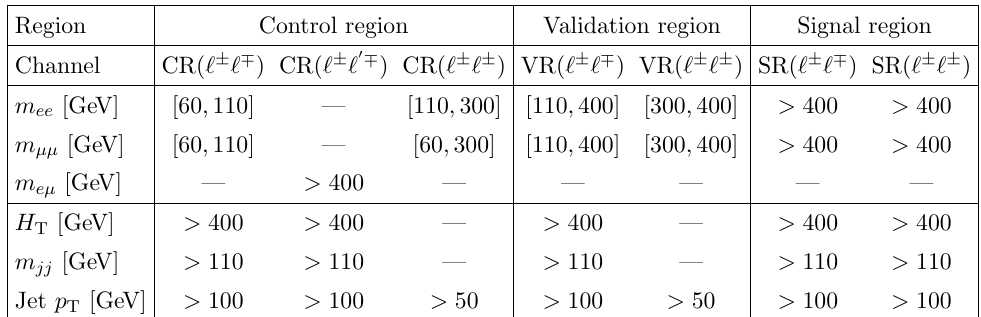
Table 2 . Summary of all regions de(cid:12)ned in the analysis divided into the OS and SS channels. The table is split into two blocks: the top half indicates the mass range of the dilepton (cid:12)nal state, whereas the bottom half indicates the event selection criteria used for a given region. The (cid:13)avour combinations are summarised as follows: ‘ (cid:6) ‘ (cid:7) = f e (cid:6) e (cid:7) ; (cid:22) (cid:6) (cid:22) (cid:7) g , ‘ (cid:6) ‘ (cid:6) = f e (cid:6) e (cid:6) ; (cid:22) (cid:6) (cid:22) (cid:6) g , ‘ (cid:6) ‘ 0 (cid:7) = f e (cid:6) (cid:22) (cid:7) g . Pairs of values [ X; Y ] indicate the minimum and maximum values the quantity in question may take in the analysis region in